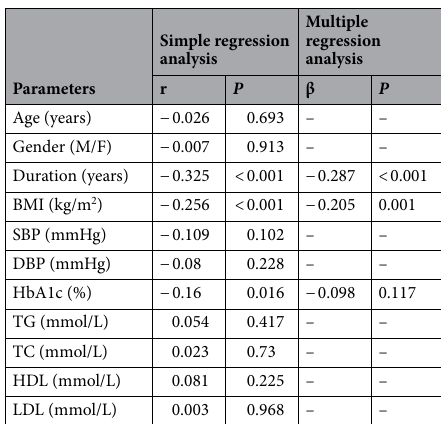
Table 4. The correlation between serum myonectin concentrations and various parameters. Abbreviation as Table 1. The correlation between serum myonectin and other parameters were analyzed using simple linear regression analysis. Then the variables with a P < 0.05 were entered into a multiple linear regression model to determine the contribution of various factors to serum myonectin.